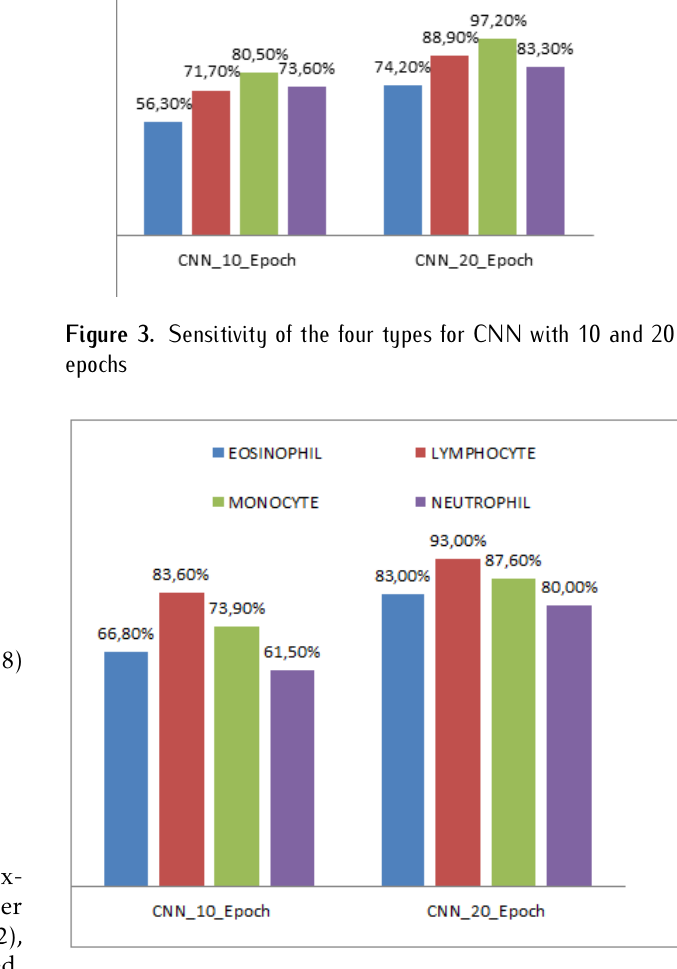
Figure 4. Negative predictive value of the four types for CNN with 10 and 20